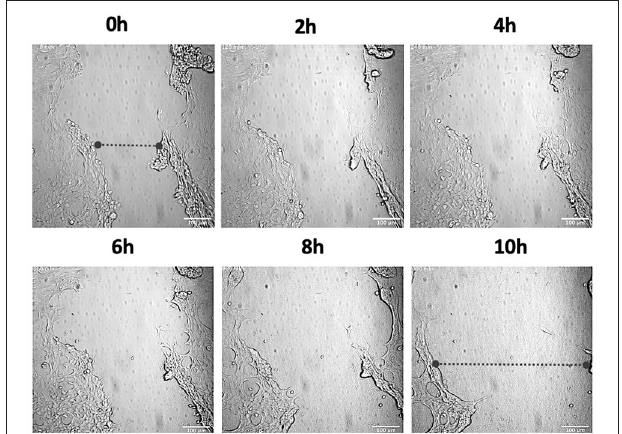
FIGURE 1 | Activation of hPg by AP53R + S − causes wound retraction of keratinocytes. Scratch wounds were produced on confluent HaCaT keratinocytes using a 27g needle prior to incubation with GAS. The cells were then incubated with AP53R + S − at MOI 5 along with the addition of 7 µ g/ml hPg prior to live imaging. Images were obtained every 10min for 10h for the duration of the imaging experiment. Time-lapsed images of the experiment are shown here (see Supplementary Video 1 ). The dashed lines show the approximate width of wound at the start and end of the experiment.